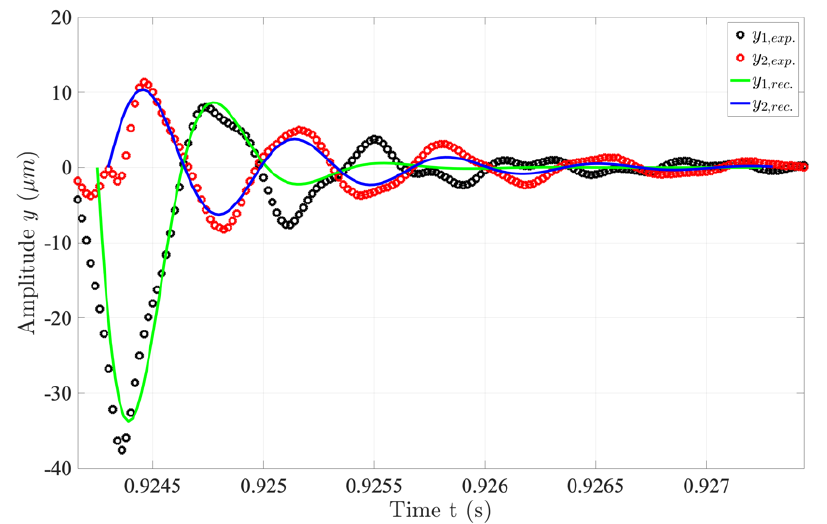
Figure 4. Example time signals at 0.5 MPa supply pressure.